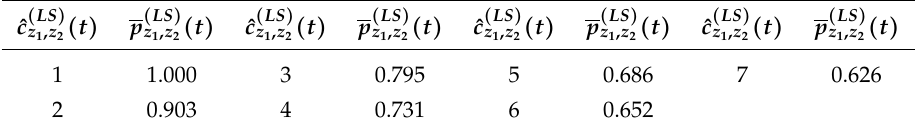
Table 2. Mapping between the cost estimate ˆ c of successful transmissions that maps into ˆ c